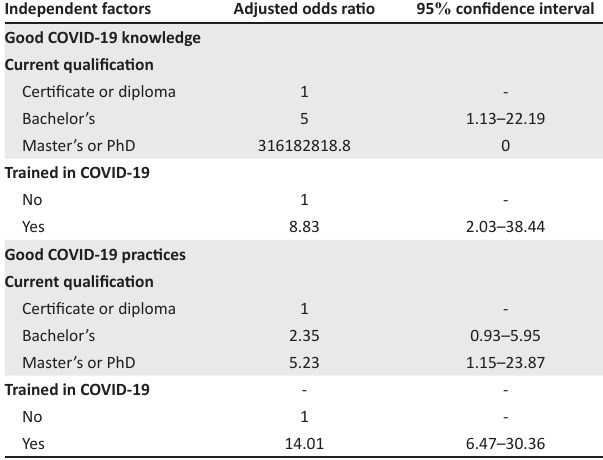
TABLE 7 : Factors independently associated with good COVID-19 knowledge and practice, Zambia, June